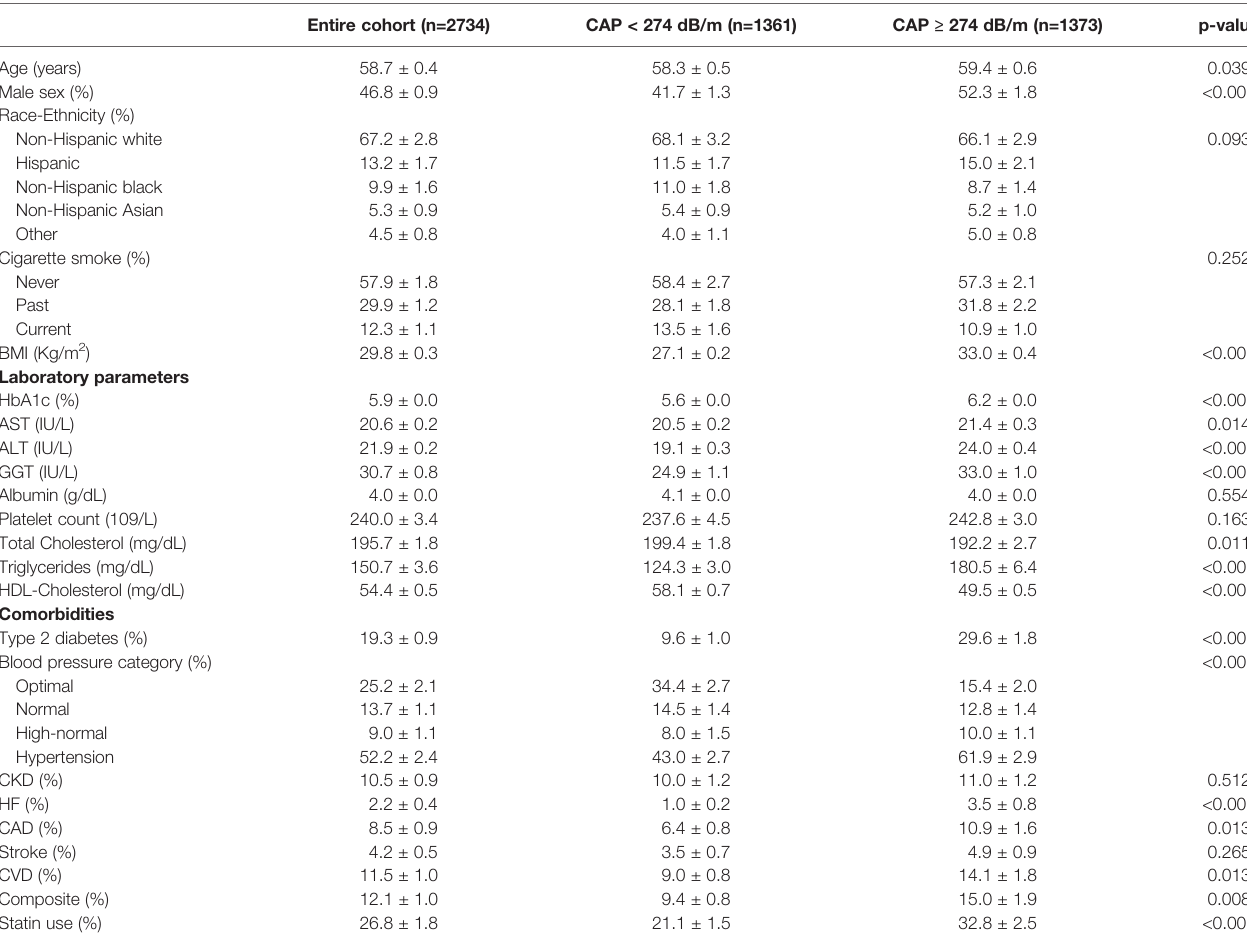
TABLE 1 | Features of the study population according to the presence of liver steatosis assessed by the controlled attenuation parameter (CAP). Entire cohort